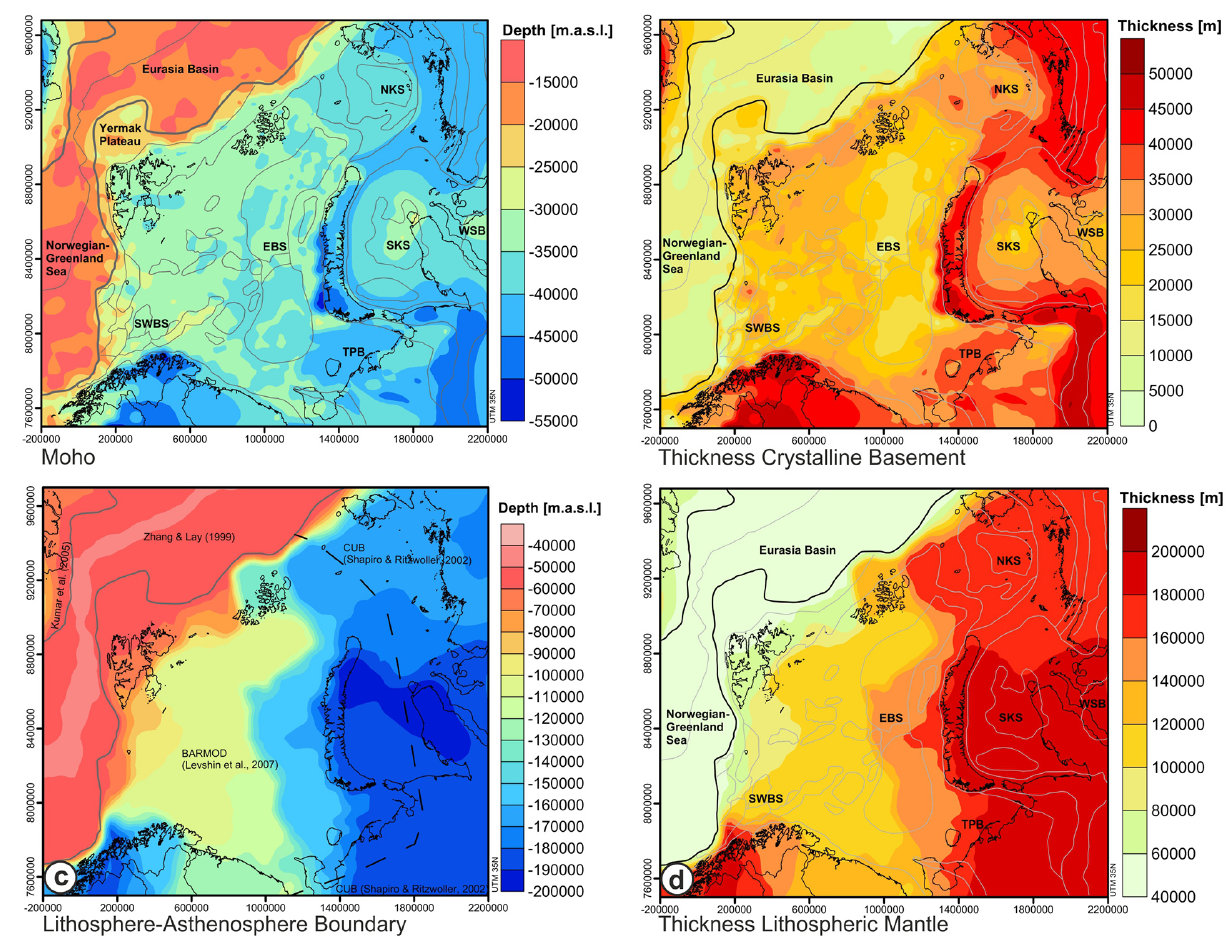
Figure 5. Structure of the deeper crust and the upper mantle: (a) depth to the Moho; (b) thickness of the crystalline crust; (c) depth to the lithosphere–asthenosphere boundary (LAB); (d) thickness of the lithospheric mantle. See Table 1 for the database. (EBS) – eastern Barents Sea; (NKS) – northern Kara Sea; (SKS) – southern Kara Sea; (SWBS) – southwestern Barents Sea; (TPB) – Timan–Pechora Basin; (WSB) – West Siberian